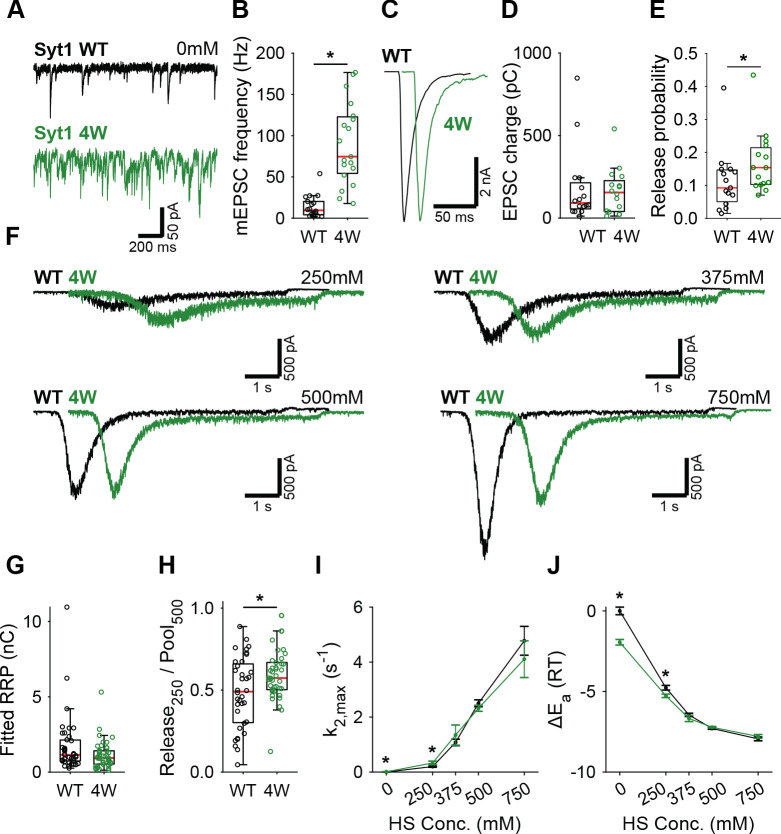
Syt1 4W mutation increases HS release rates only at low concentration.(A) Representative traces of spontaneous release (0 mM HS), and (B) boxplot of spontaneous frequency in Syt1 WT and Syt1 4W expressing synapses. (C) Representative traces of AP-evoked release in Syt1 WT and Syt1 4W, overlaid with 20 ms offset, and (D) boxplots of charge transferred during the first evoked EPSC and (E) release probability calculated by dividing the EPSC charge by the HS-derived RRP charge (G). (F) Representative traces of HS-induced release in Syt1 WT and Syt1 4W, overlaid with 1 s offset, at 250 mM, 375 mM, 500 mM, and 750 mM HS, and boxplots of (G) RRP charge estimated from 500 mM HS, (H) depleted RRP fraction at 250 mM HS in Syt1 WT and Syt1 4W. (I) Plots (mean ± S.E.M.) of maximal HS release rates, and (J) change in the fusion energy barrier at different HS concentrations for Syt1 WT and Syt1 4W. (*p<0.05, Wilcoxon rank sum test).
Figure 3—figure supplement 2—source data 1.Statistics overview.